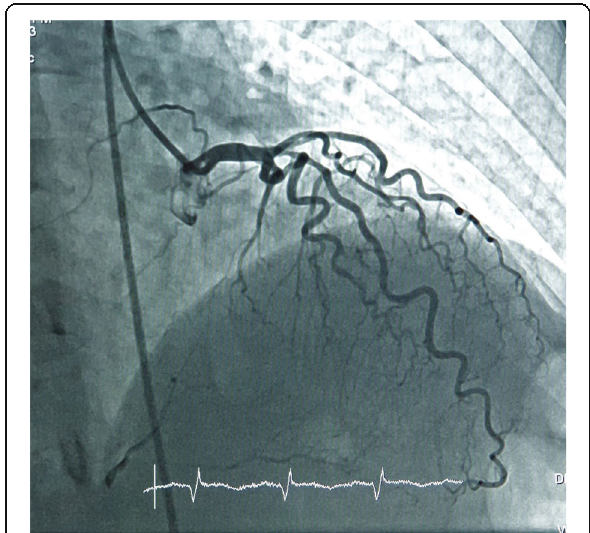
Fig. 1 Left side coronary angiogram